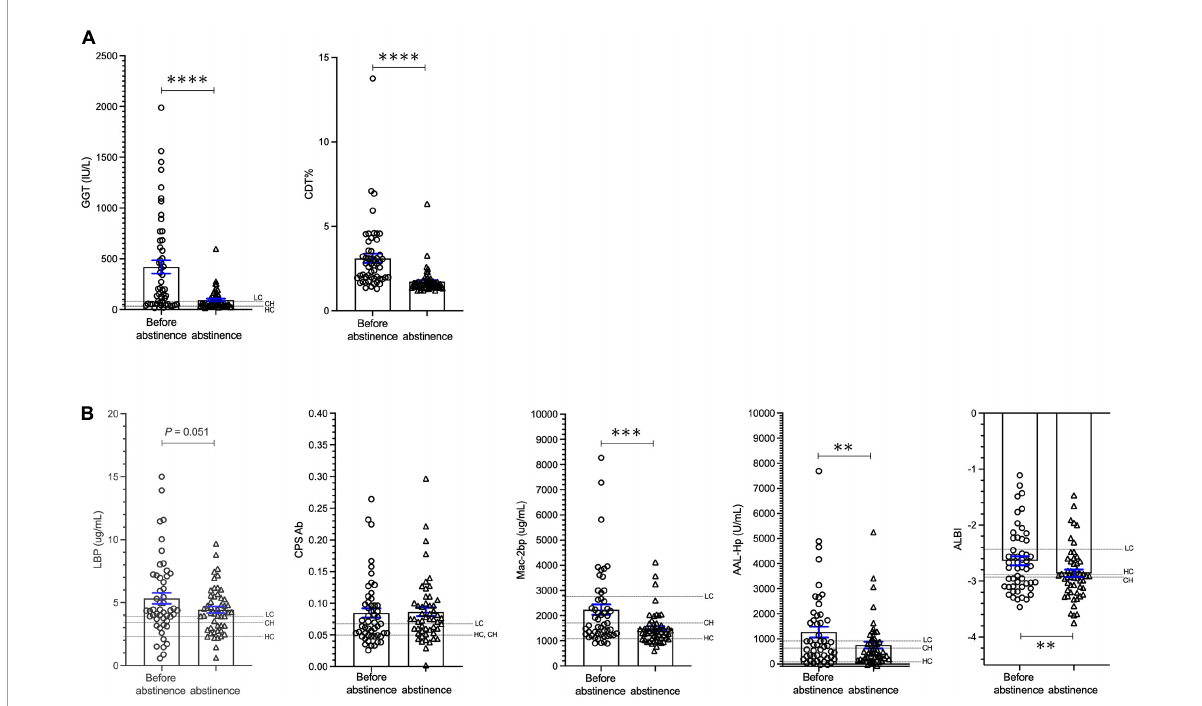
FIGURE4 Changes in biomarkers in patients with ALD during alcohol cessation. (A) Changes in GGT and CDT. (B) Changes in LBP, E. CPS, Mac-2 bp, AAL-Hp and ALBI. GGT, glutamyl-transferase; CDT, carbohydrate deficient transferrin; LBP, lipopolysaccharide-binding protein; E. CPS, E. faecalis capsular polysaccharide; Mac-2 bp, Mac-2 binding protein; AAL-Hp, aleuria aurantia lectin-haptoglobin; ALBI, albumin-bilirubin; HC, healthy control; CH, chronic hepatitis; LC, liver cirrhosis. The mean values in HC, CH and LC subjects are indicated. ∗∗ p < 0.01, ∗∗∗ p < 0.001, ∗∗∗∗ p <